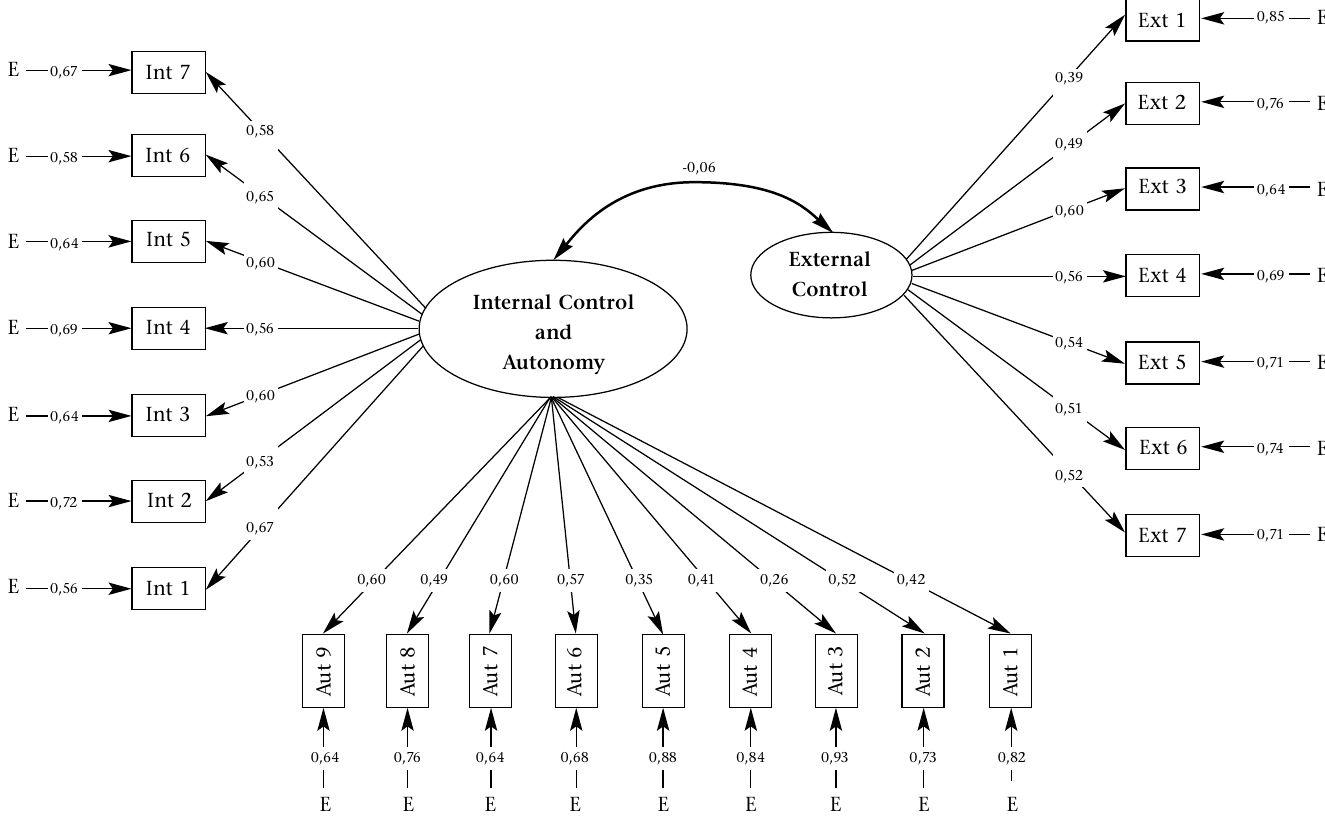
Figure 4: Standardised parameters for the two-factor LCI model in respect of the Black group